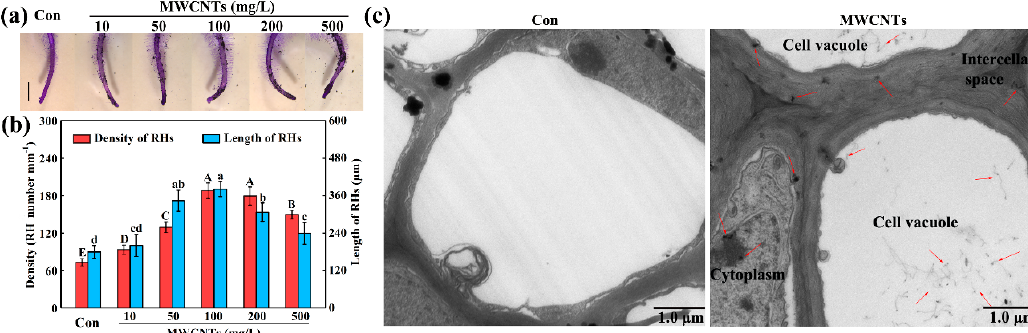
Figure 1. MWCNTs induced rapeseed root hair growth and the distribution of MWCNTs. Two-day-old seedlings were treated with the indicated concentrations of MWCNTs for 3 days. The sample without chemicals was the control (Con). Afterward, photographs of root hairs were taken after staining with 1% toluidine blue ( a ). Scale bar = 1 mm. Meanwhile, the root hair (RH) density ( b ; left ) and length (right) were measured. Within each set of experiments, bars with different letters are significantly different at p < 0.05 according to Duncan’s multiple range test. The distribution of MWCNTs was detected in rapeseed root tissues in response to 100 mg/L MWCNTs ( c ). The red arrows point to MWCNTs. The distribution of MWCNTs was further detected by using transmission electron